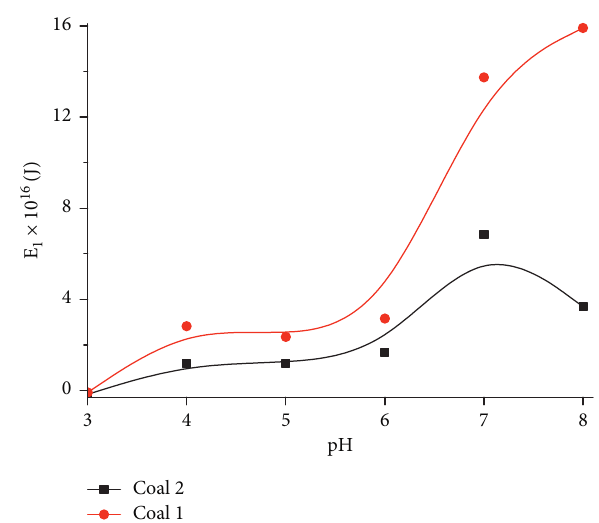
Figure 7: Energy barriers for the coal samples and air bubble at different pH